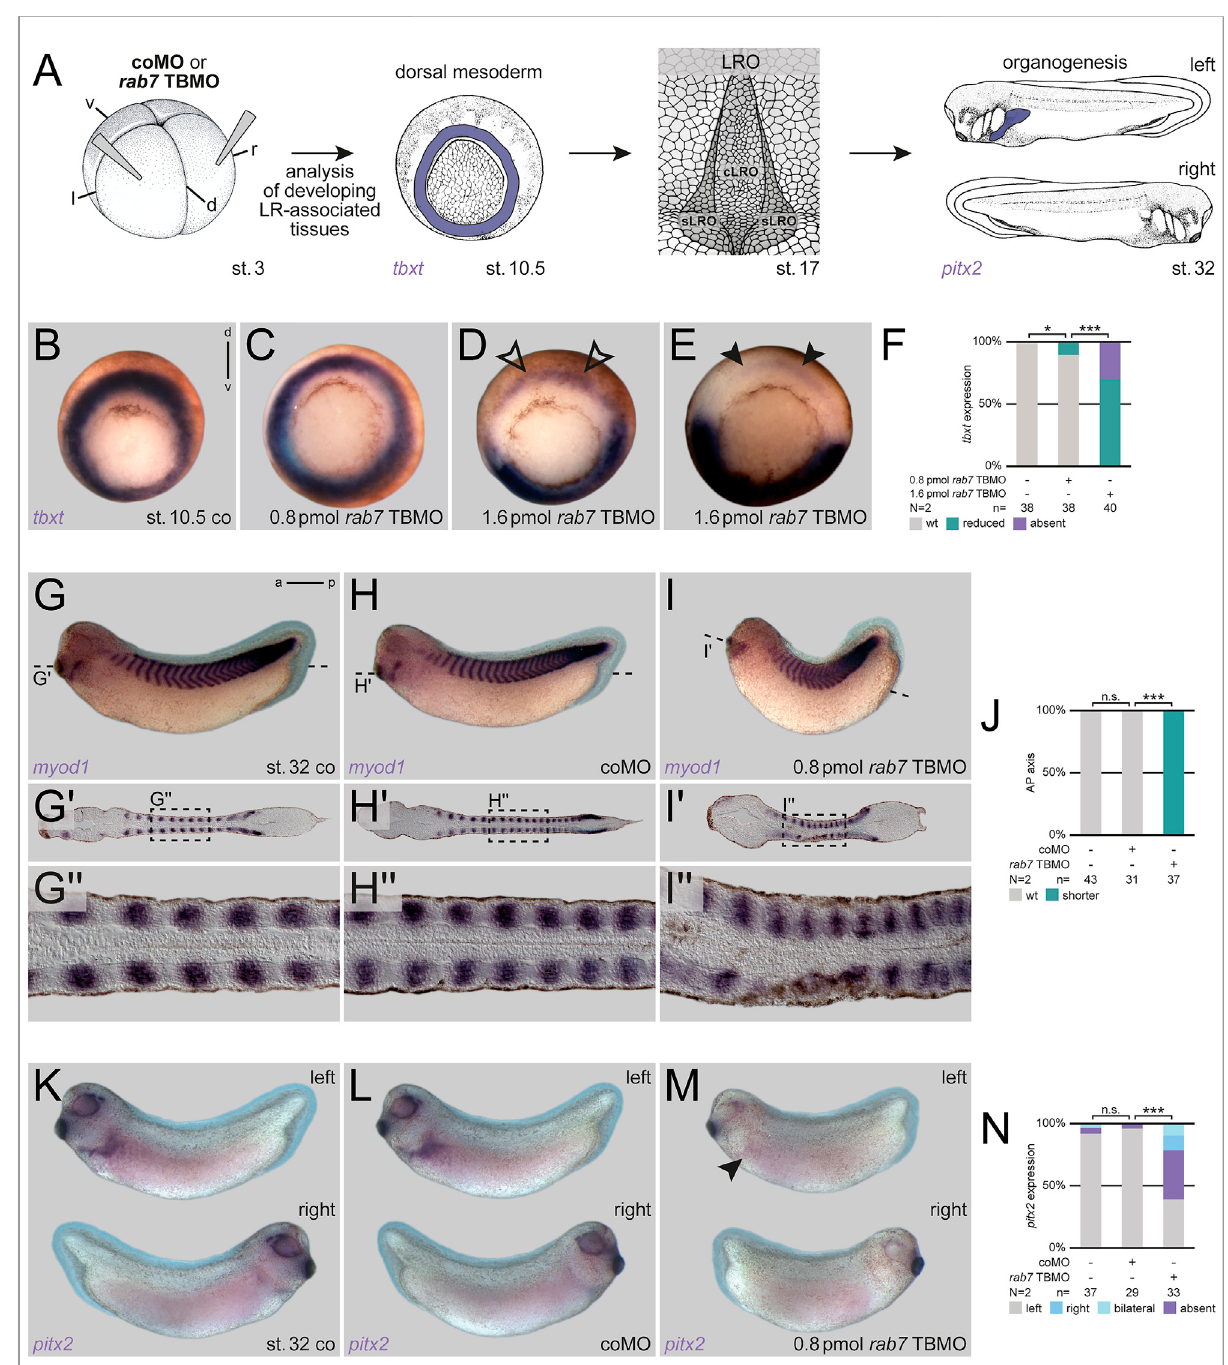
FIGURE 1 Rab7isnecessaryforcorrectLRaxisdevelopment. (A) Experimentalsetupfortheshownexperiments:Injectionsatfour-cellstage(left)targeted the dorsal mesoderm to analyze mesoderm speci fi cation ( tbxt ; middle-left) at gastrula stages, a prerequisite for the formation of the dorsal mesoderm derived LRO (middle-right) in wild type situation during neurula stages, which in turn induces LR asymmetric features (here pitx2 expression; right) at tailbud stages. (B) Wild type circular tbxt expression of st. 10.5 control specimen, (C) injection of reduced amounts of rab7 TBMO did not alter tbxt expression, (D) whereas higher doses reduced transcripts (black outlined arrowheads) or (E) abolished them in the targeted dorsal lineage (black arrowheads). (F) Quanti fi cation of tbxt expression. (G) Uninjected st. 32 tadpole, or specimen injected with (H) coMO depicted wild type axis elongation compared to (I) shortened axis of rab7 TBMO treated specimens. (G 9 – I 9 ) Please note in frontal sections through somitic lineage that all specimen showed myod1 expression in somites along AP-axis. (G 99 – I 99 ) Magni fi cation of myod1 expressing somites as indicated in dashed boxes, respectively. Please note altered somite shapes in morphants. (J) Quanti fi cation of axis phenotype. (K) Left-sided pitx2 expression in untreated st. 32 tadpoles and (L) coMO injected ones. (M) Lost left-sided pitx2 expression upon rab7 knockdown (black arrowhead). (N)